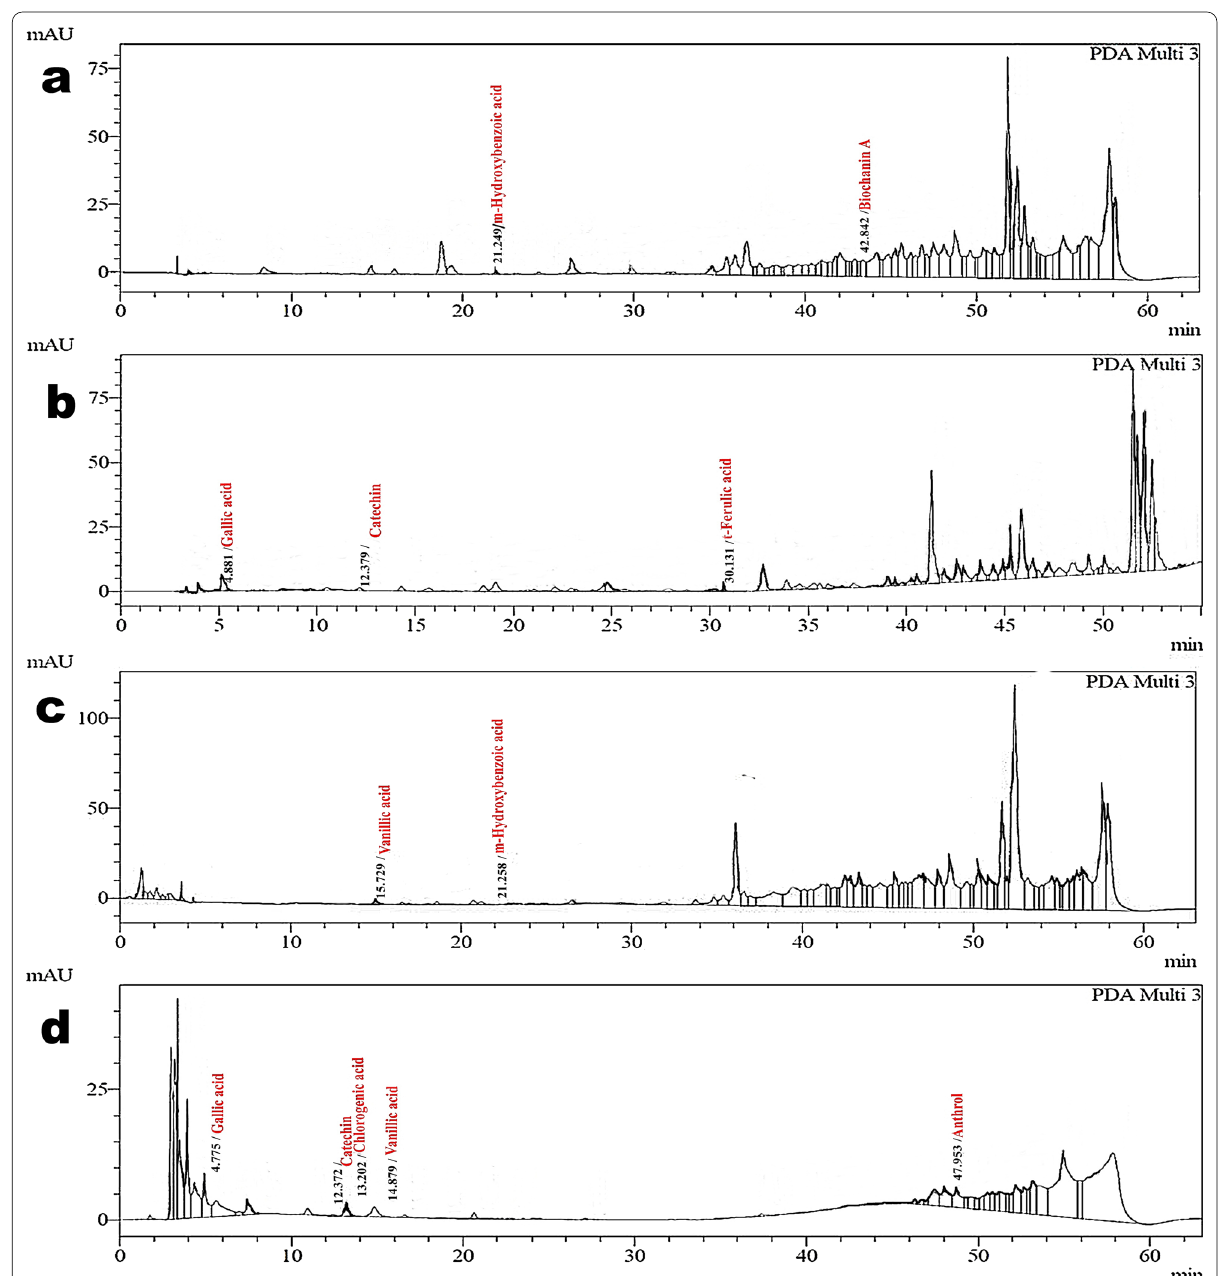
Fig. 3 Chromatograms of petroleum benzene extracts of four species of Saraca a S. asoca , b S. declinata , c S. indica and d S .